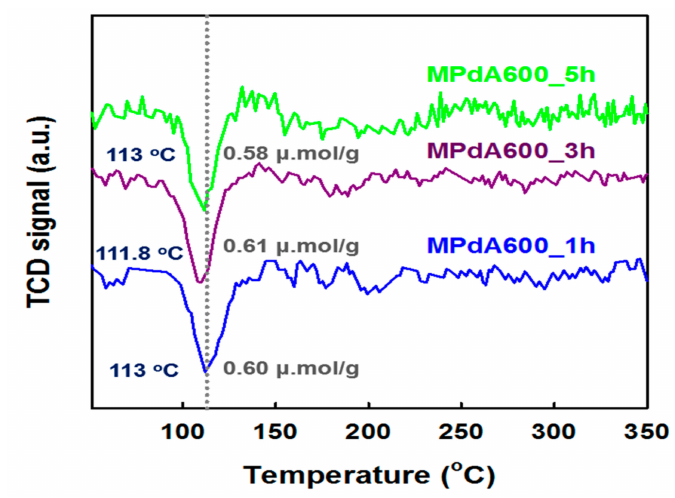
Figure 9. H 2 -TPR profiles of the MPdA catalysts calcined at 600 ◦ C for di ff erent durations.